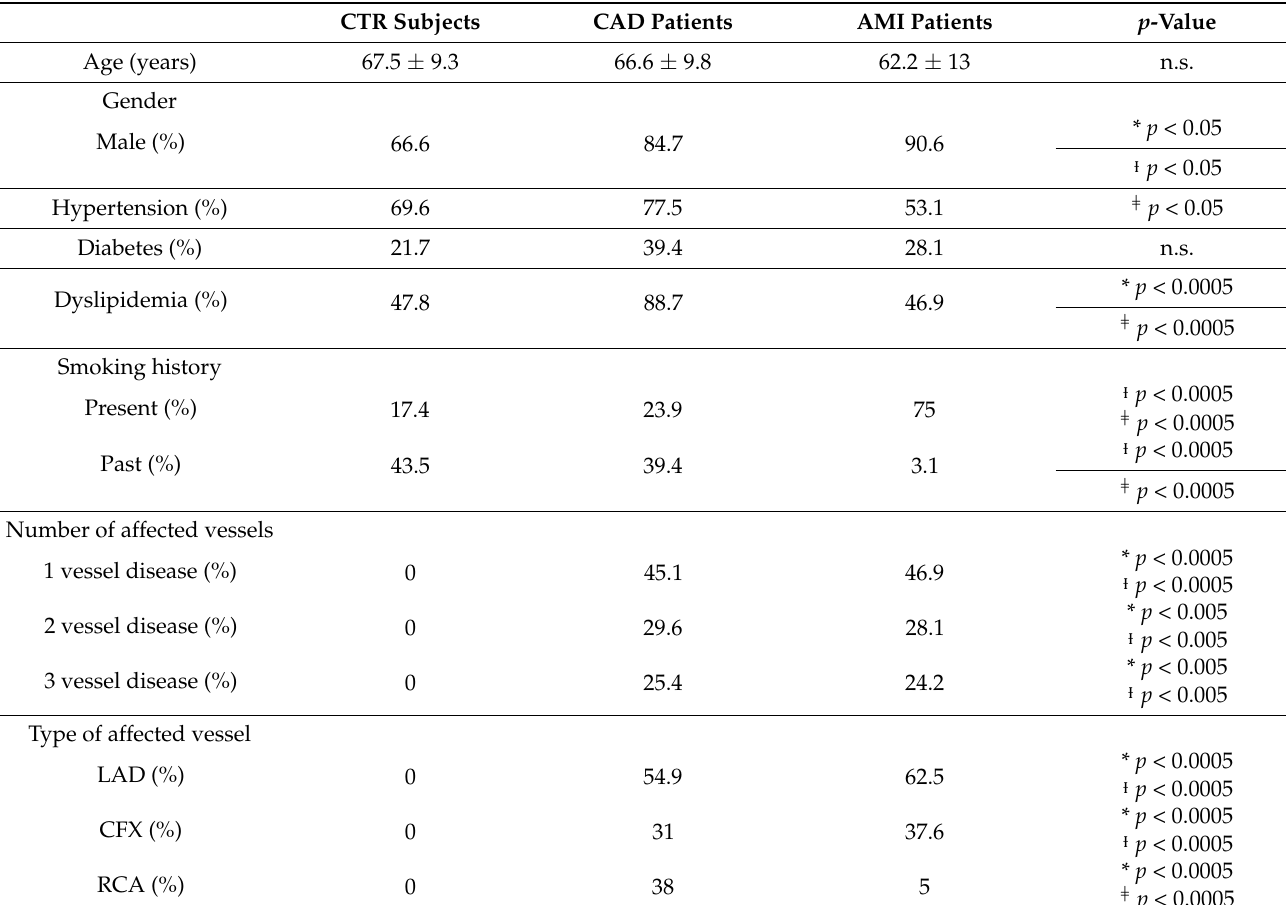
Table 4. Clinical features of CTR, CAD, and AMI patients studied.